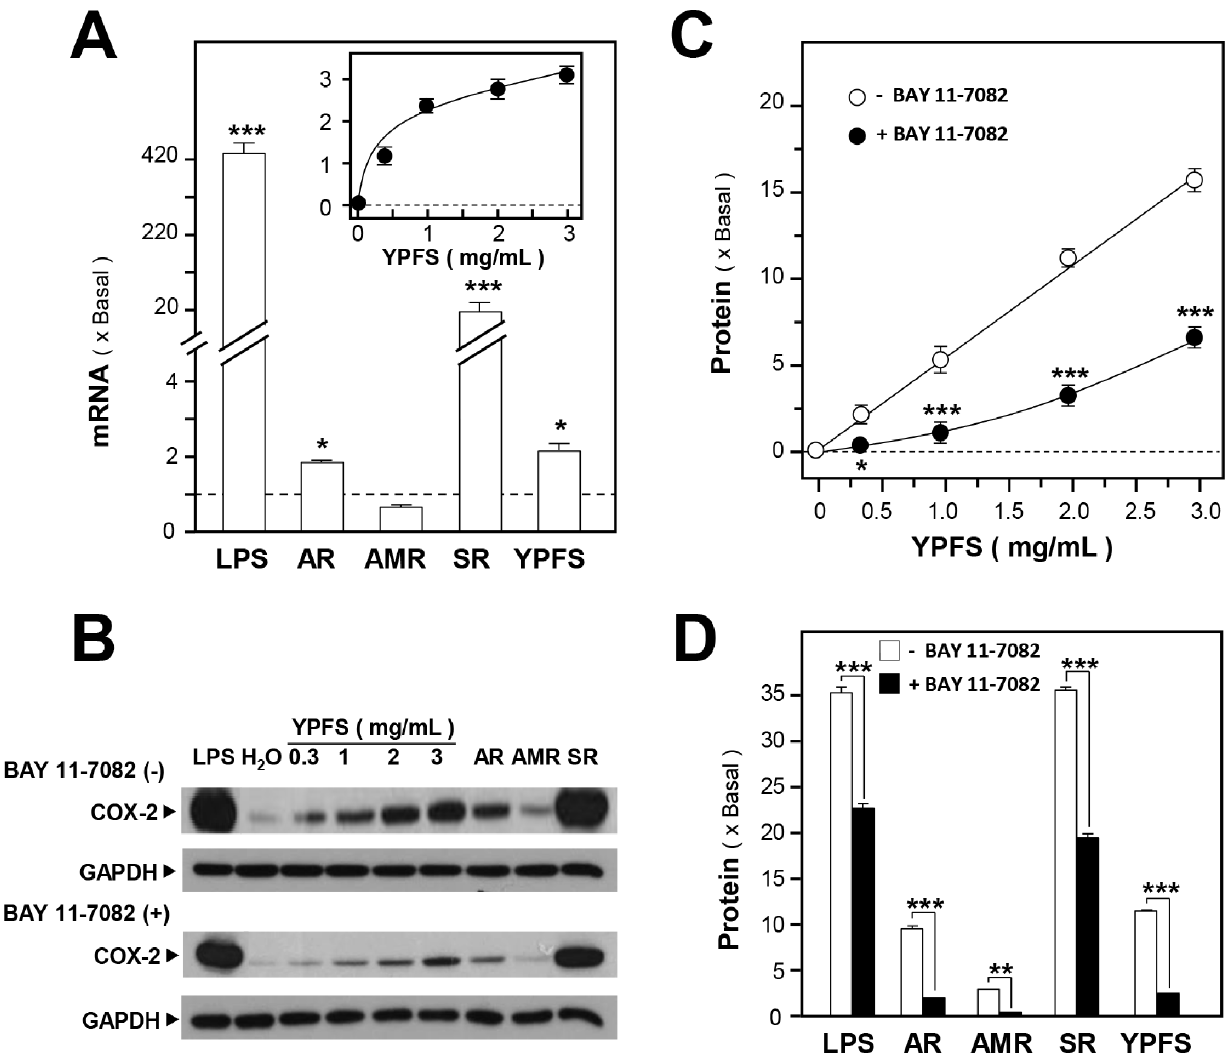
Figure 5. YPFS induces COX-2 expression in macrophages. ( A ): Cultured macrophages were treated with herbal extracts as described in Fig. 4 legend for 24 hours and then COX-2 mRNA expression levels were determined using RT-PCR. GAPDH was used as an internal control for normalization and LPS (1 m g/mL) was used as the positive control. ( B ): Macrophages were treated with herbal extracts for 24 hours after first incubating the cells with or without the NF- k B-specific inhibitor BAY 11-7082 (5 m M) for 3 hours. Cell lysates were collected, diluted to equal protein concentrations, and analyzed by means of western blotting. Representative western blots are shown. ( C ): Effects of BAY 11-7082 on the expression of COX-2 protein induced by YPFS in cultured macrophages. ( D ): Effects of BAY 11-7082 on COX-2 protein expression induced by individual herbs in cultured macrophages. Results in (C) and (D) were calculated using the western blots shown in (B). Values were normalized using the internal control GAPDH and are expressed as fold-increases relative to basal reading (untreated cultures); mean 6 SD are shown, n =5, each with triplicate samples. * p , 0.05; ** p , 0.01; *** p , 0.001.